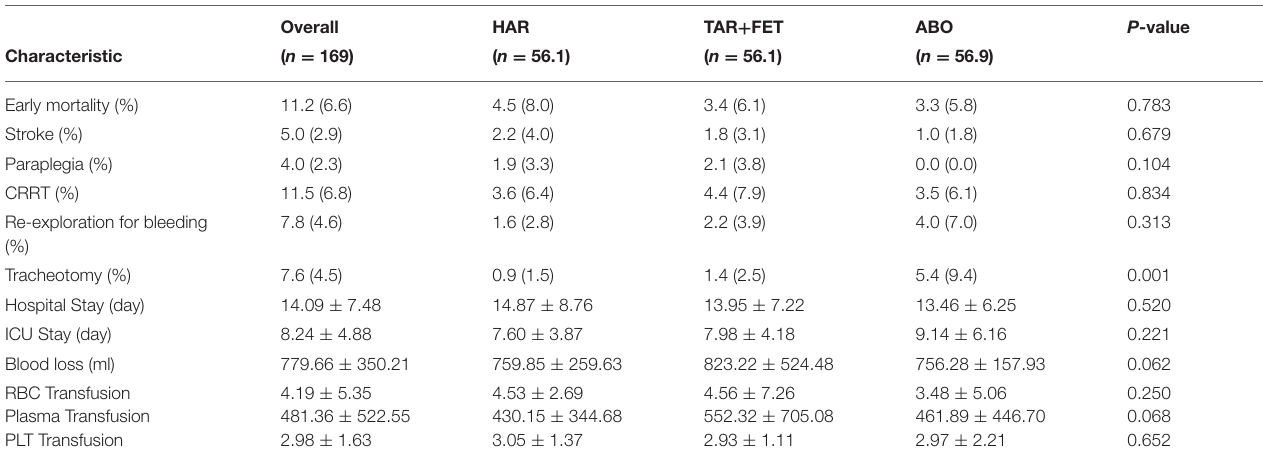
TABLE 6 | Early outcomes for the total cohort and each group after using the matching weight method. Overall HAR TAR + FET ABO P